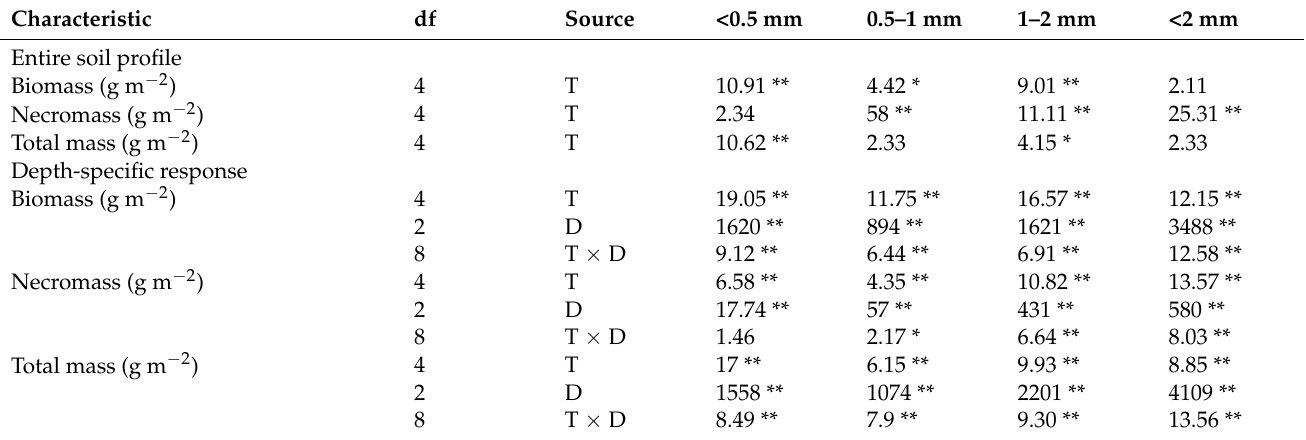
Figure 2. The effects of thinning intensities on the fine-root biomass, necromass, and total mass (average over four seasons) among different diameter classes at different soil depths ( a – c , e – g , i – k ), and the entire soil profile ( d , h , l ). The values are the mean of four replicates ± SE. CK, T1, T2, T3, and T4 represent 0%, 15%, 30%, 45% and 60% thinning intensities, respectively. Different lowercase letters (a, b, c, d) indicate significant differences for the same diameter class fine roots among the thinning intensities ( p < 0.05). Table 3. The effects of the thinning intensity (T) on the mean annual biomass, necromass, and total biomass of fine roots over the entire soil profile, and at specific depths (D).